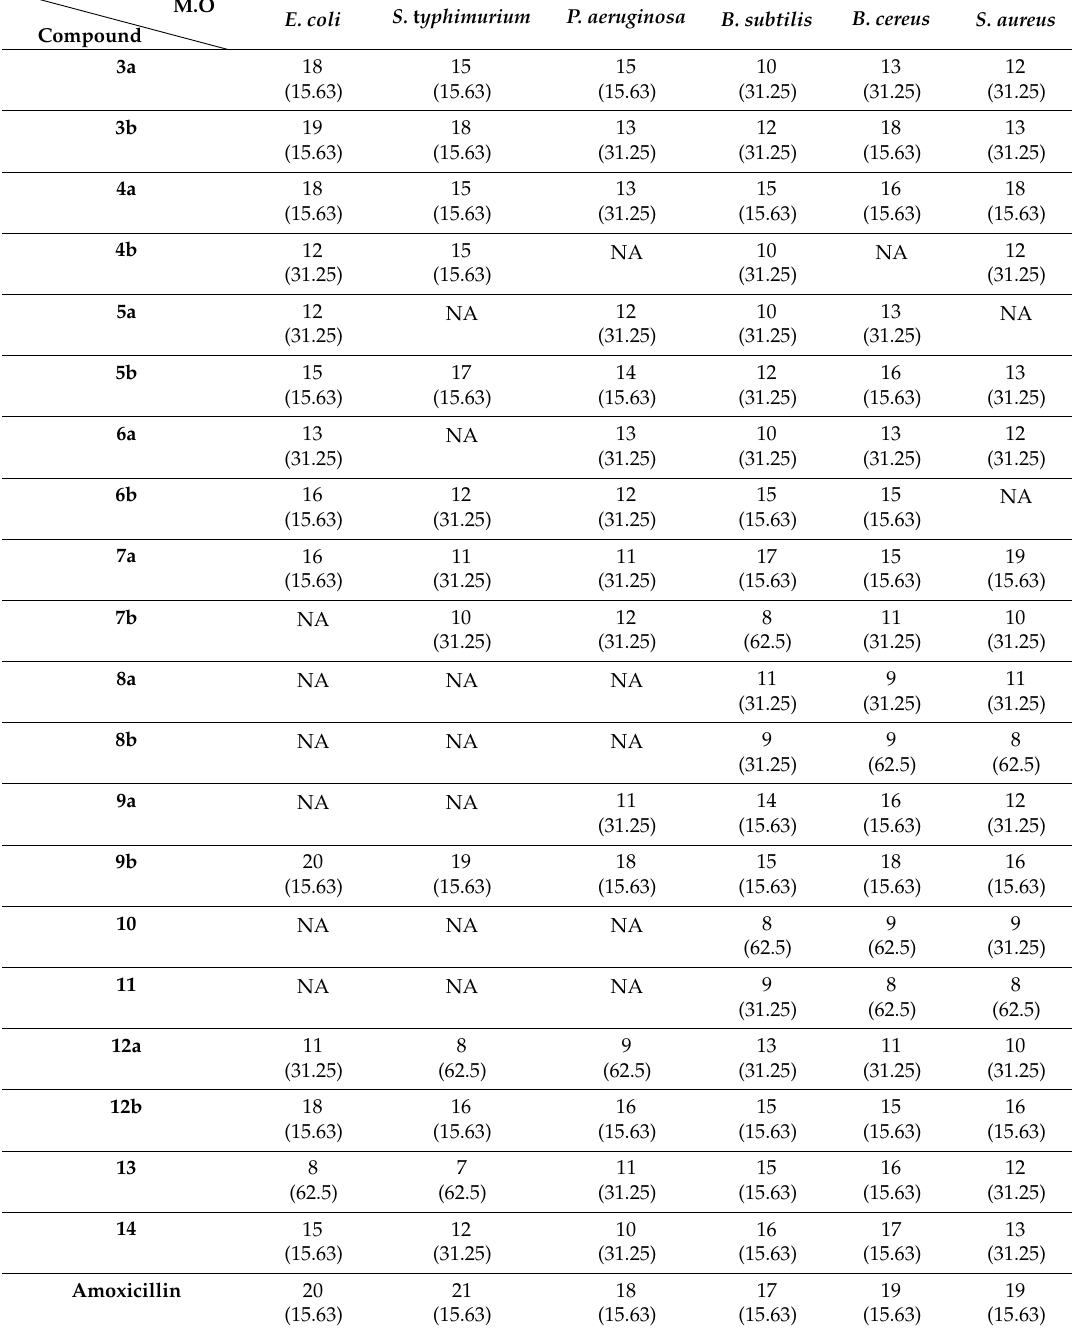
Table 1. The diameter of inhibition zones (mm) and minimum inhibitory concentration (MIC) values ( µ g / mL).